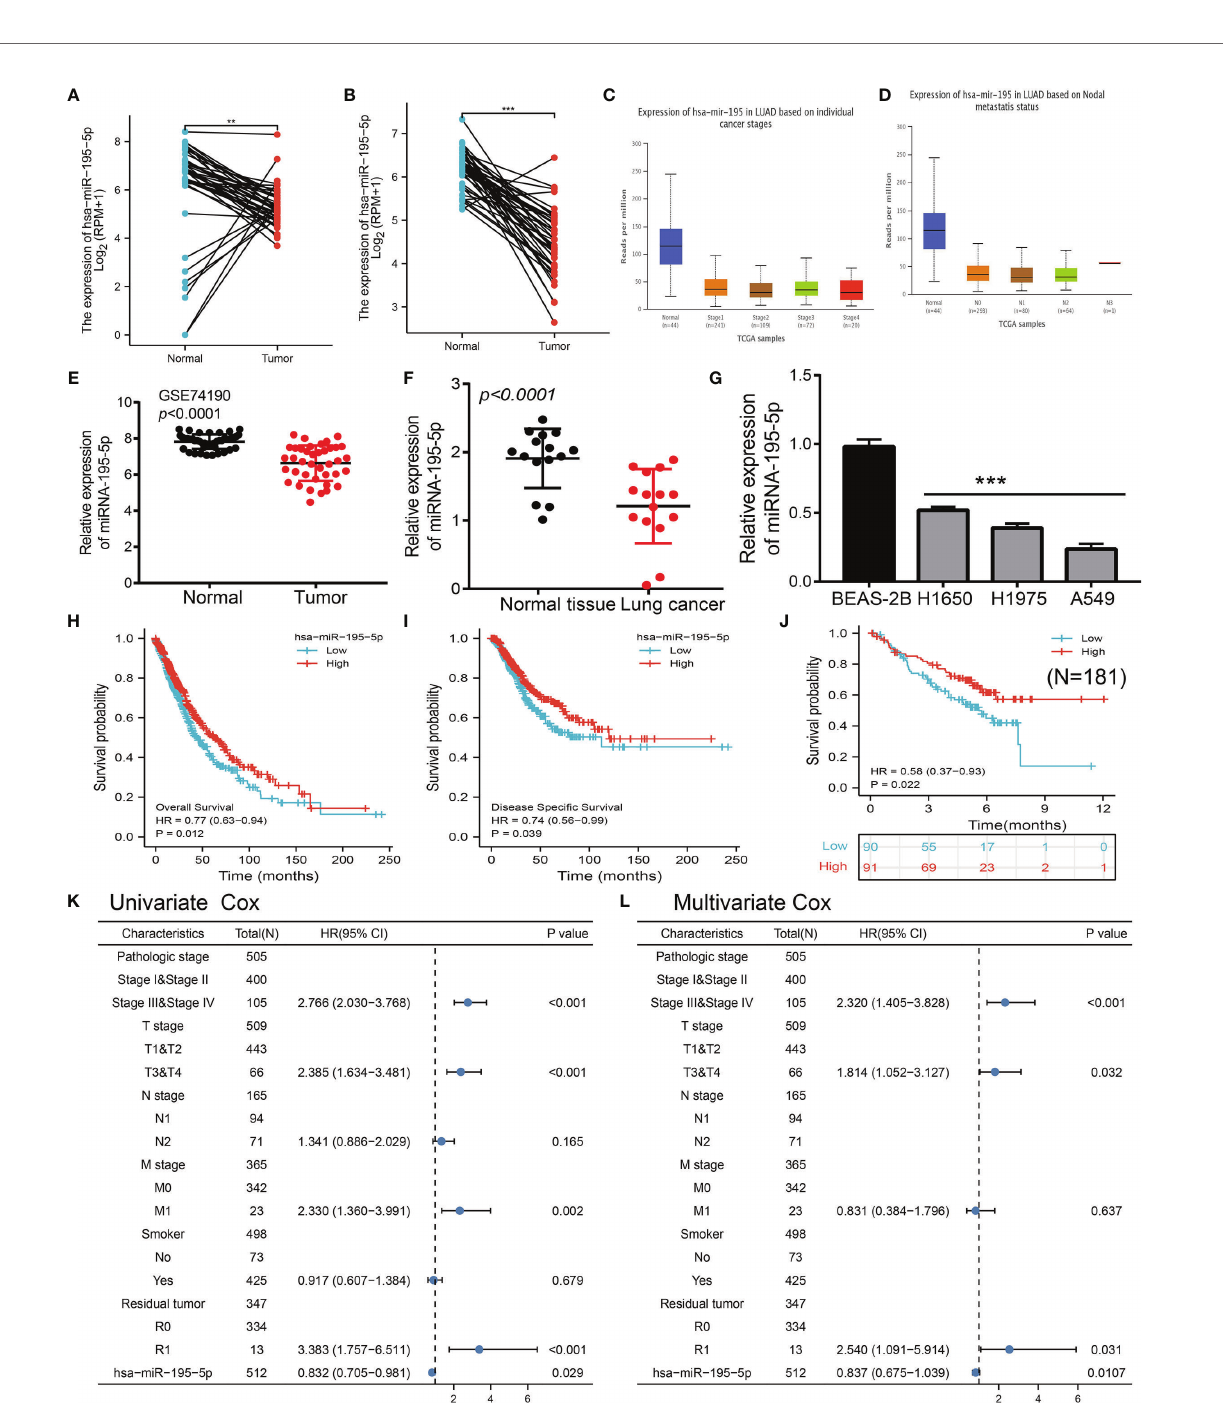
FIGURE 4 | miRNA-195-5p was down-regulated in LUAD and cell lines. (A, B) The expression of miRNA-195-5p in lung cancer examine by TCGA datasets. (C) The tumor stage of miRNA-195-5p in TCGA-LUAD examine by the UALCAN. (D) The lymph node metastases of miRNA-195-5p in TCGA-LUAD examined by the UALCAN. (E, F) The expression of miRNA-195-5p in lung cancer determines by GEO datasets. (G) The expression of miRNA-195-5p in LUAD cell lines was determined by qRT-PCR assay. (H – J) The overall survival and disease-speci fi c survival of miRNA-195-5p in LUAD determine by the TCGA-LUAD dataset and clinical samples. (K, L) Univariate and multivariate Cox regression analyses were performed to determine miRNA-195-5p as an independent prognostic factor in the TCGA LUAD dataset. **P<0.01;